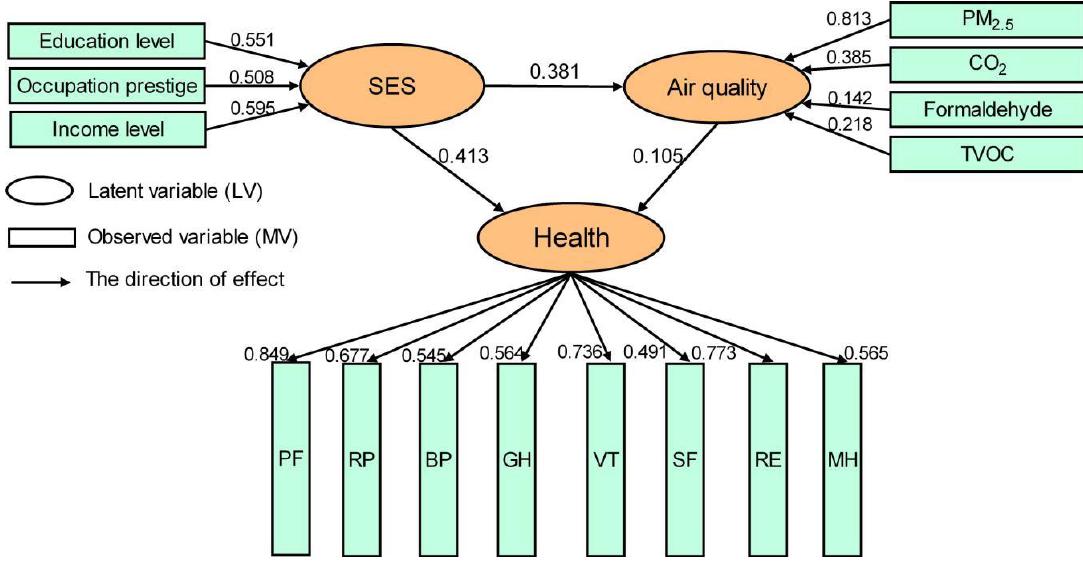
Figure 4. The model results inferred from the field measurement data (compared with Figure 3). SES-